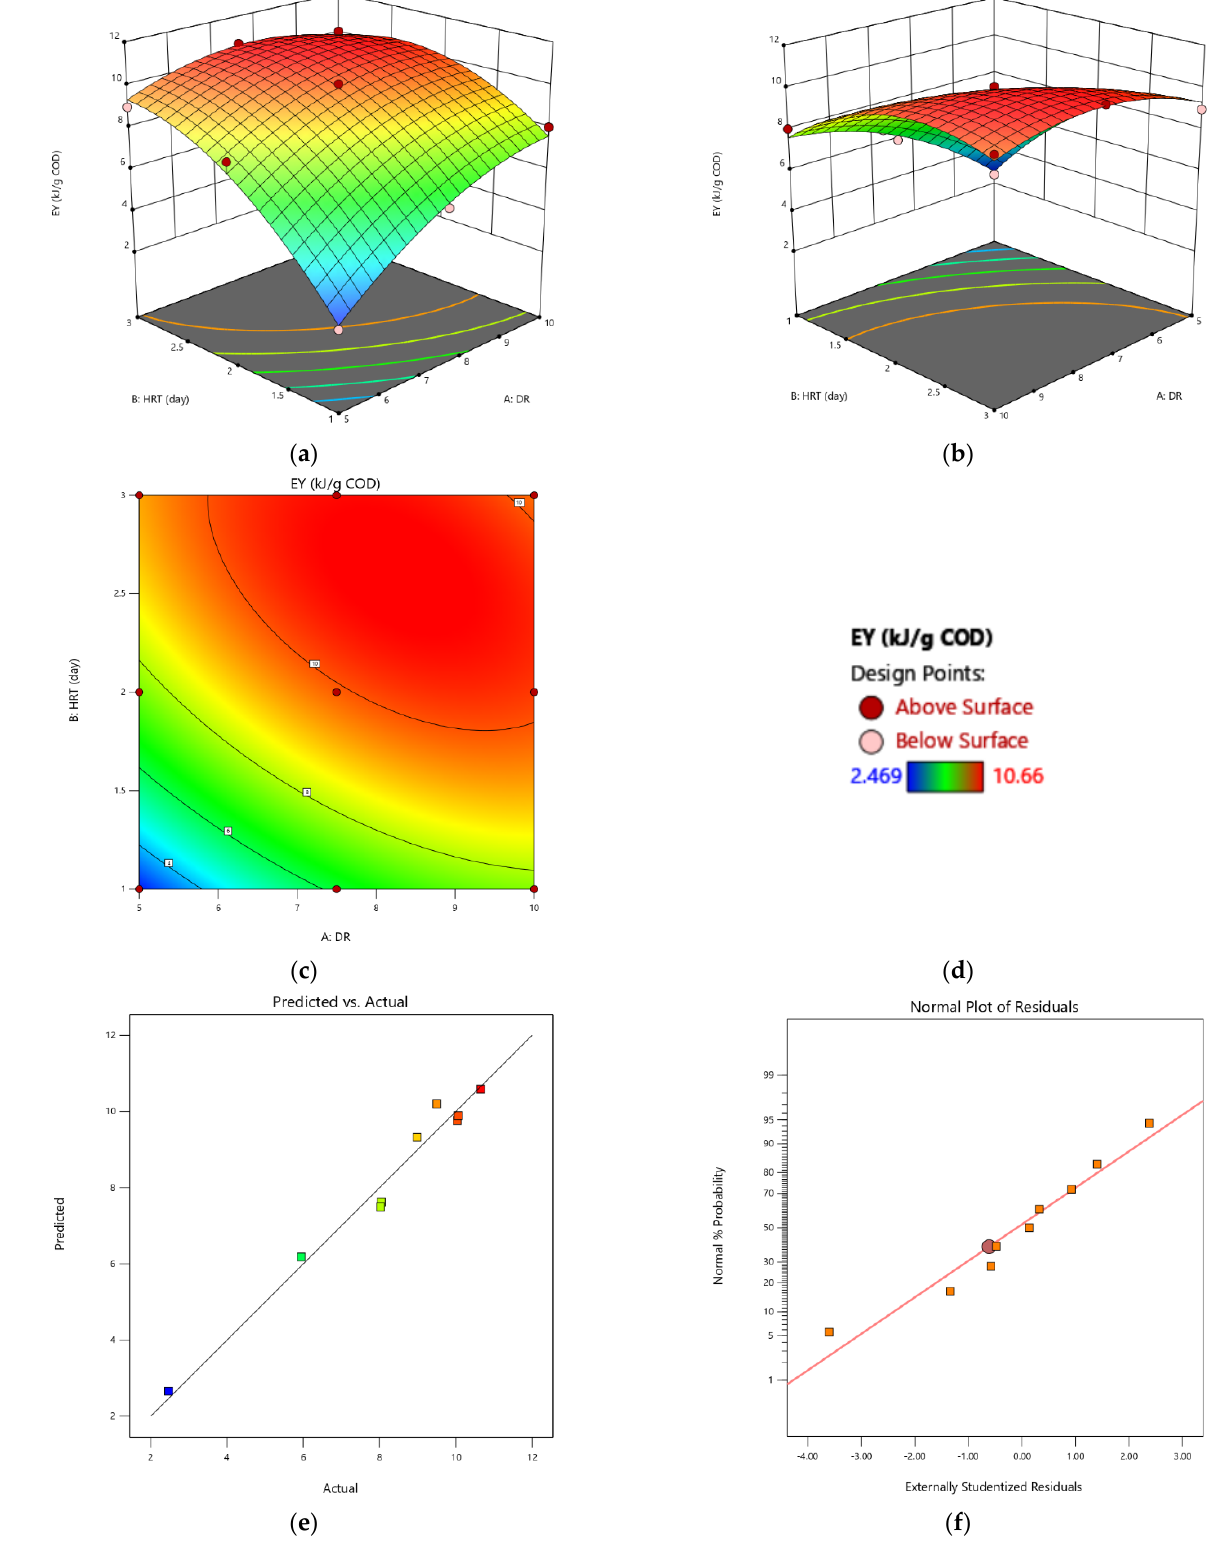
Figure 8. Interactive effect of DR and HRT on EY: ( a , b ) 3D response surface; ( c ) contour plots; ( d ) color legend; ( e ) plot of actual vs. predicted values; ( f ) normal plot of residuals.